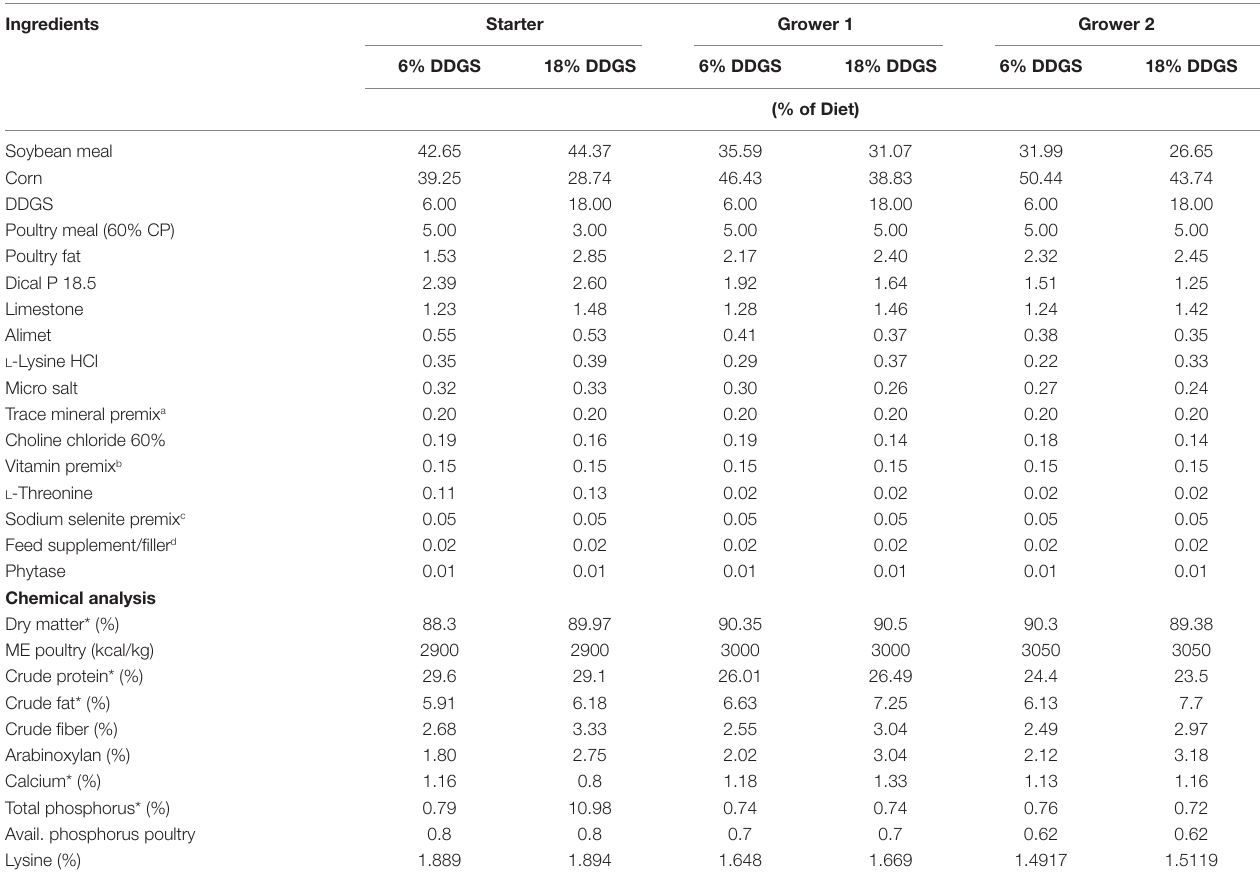
TaBle 2 | Dietary ingredients and nutrients composition fed to turkey hens in experiment 2.